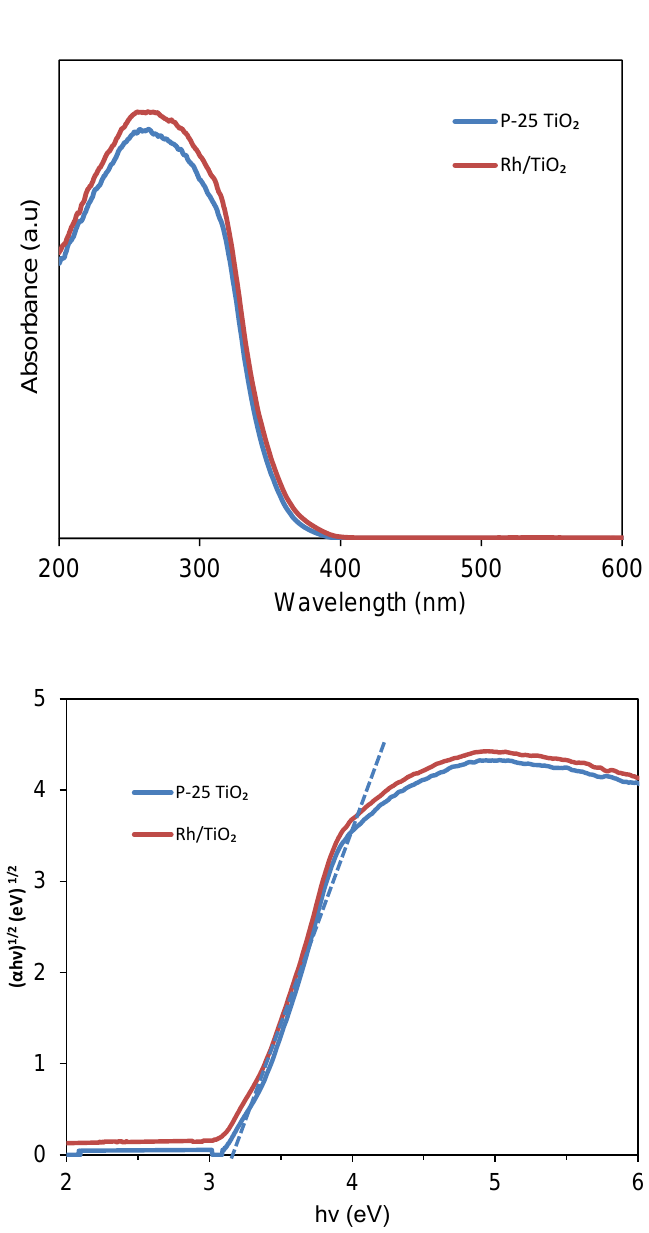
Figure 11. UV–Vis diffuse reflectance spectra ( upper ) and tauc plot ( down ) for P-25 TiO 2 and Rh/TiO 2 .